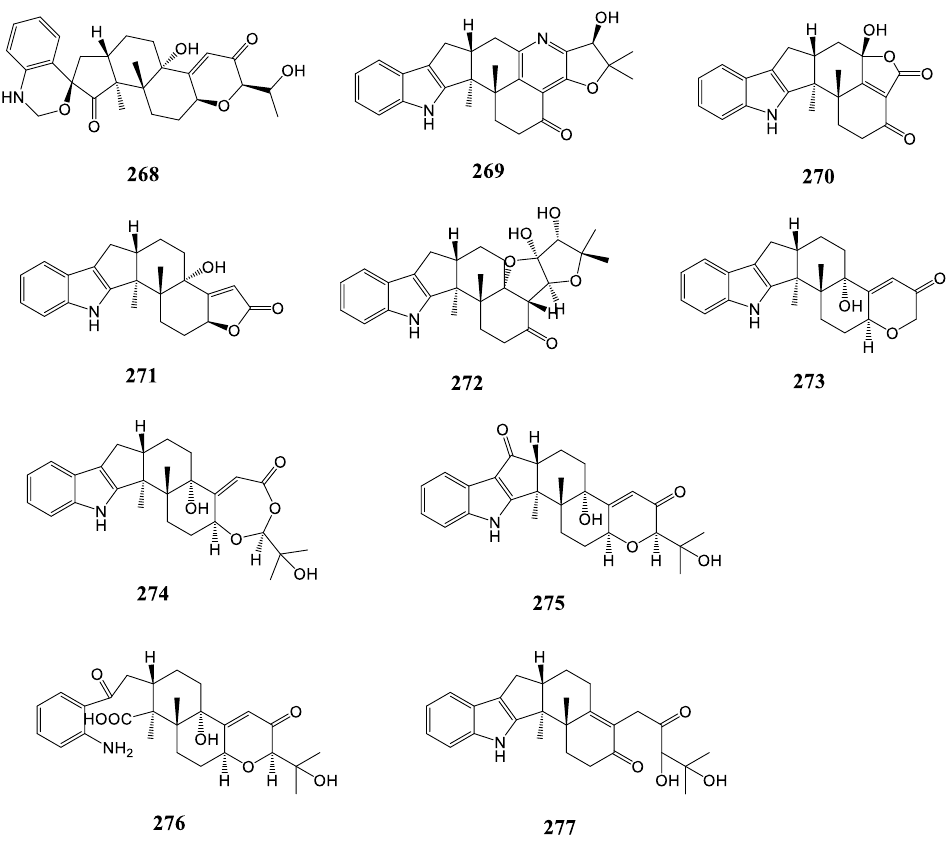
Figure 15. Structures of penerpene indole diterpenes.